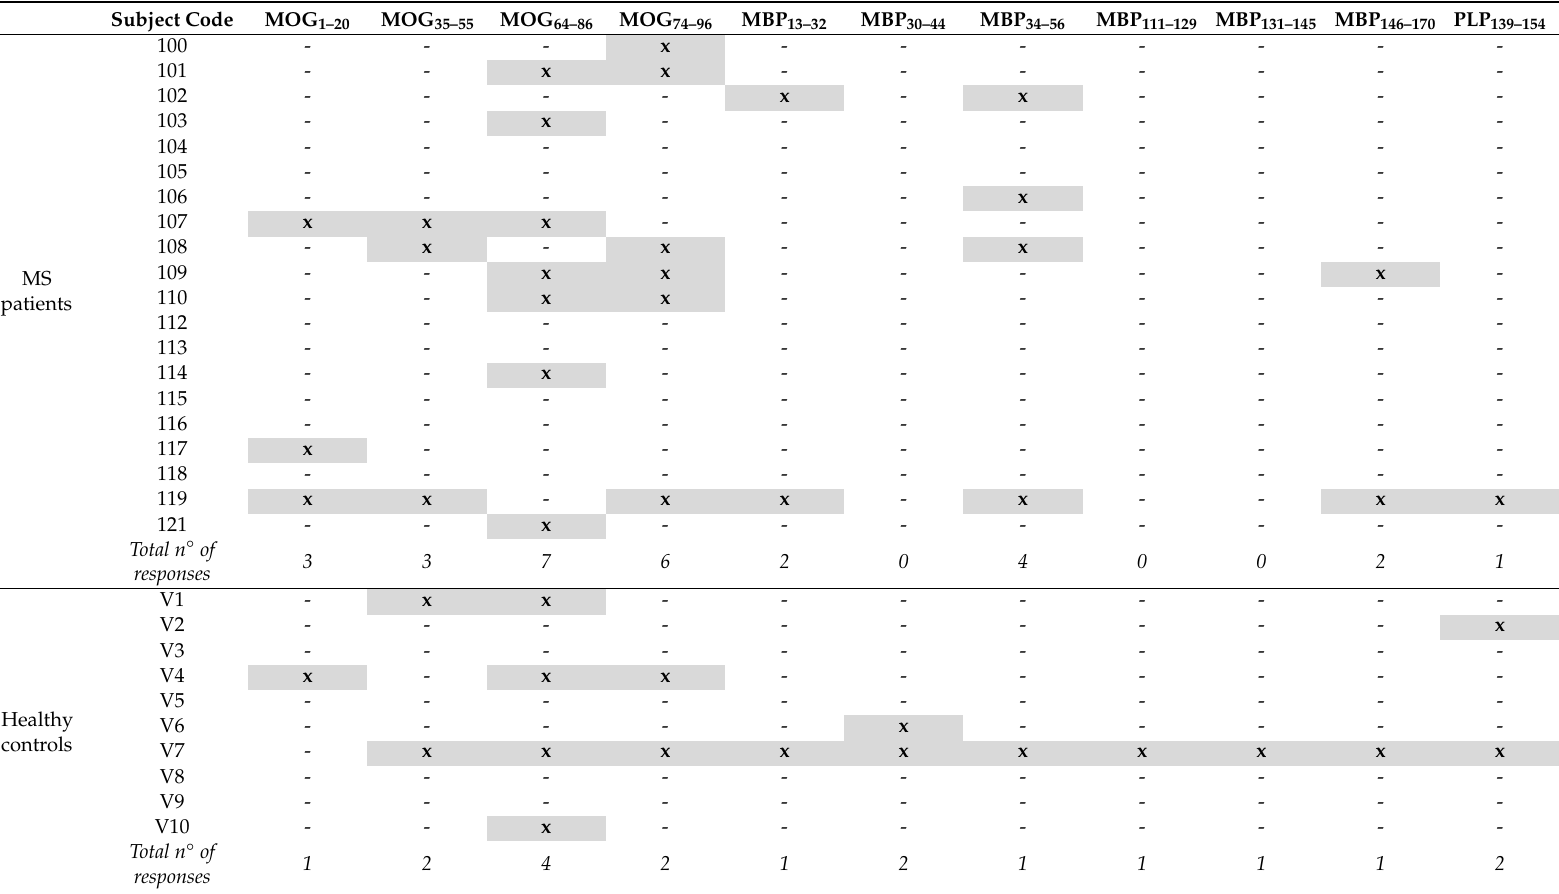
For 11 individual myelin peptides, presence of PBMC reactivity is indicated in grey. A peptide-specific response was defined as present when > 50% of the peptide-restimulated wells were positive. A well was defined as positive when the number of spot-forming cells in the well was higher than the [mean spot forming cells + 3 standard deviations (S.D.)] of